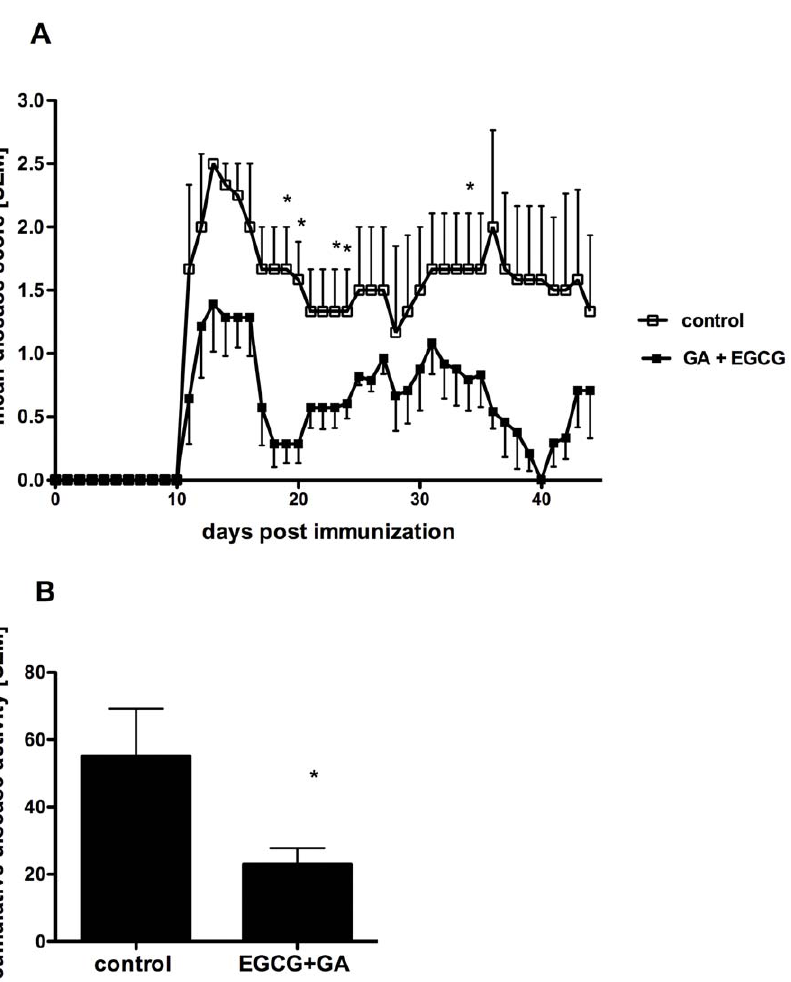
Figure 4. Combination therapy with EGCG and GA alleviates disability in established EAE. For treatment of acute disease PLP 139–151 - induced EAE mice were randomized into two groups after reaching a disease score of 2 and subsequently received 300 m g of oral EGCG or vehicle (0.9% NaCl) twice daily in addition to daily s.c. injections of 150 m g GA or vehicle (4% Mannitol). Mean disease score of control and combination therapy group is shown from day 0 to day 44 after immunization (A), *p , 0.05 day 19, 20, 23, 24, 34, n=6. Cumulative disease activity of control and combination therapy group was calculated (B), *p , 0.05.